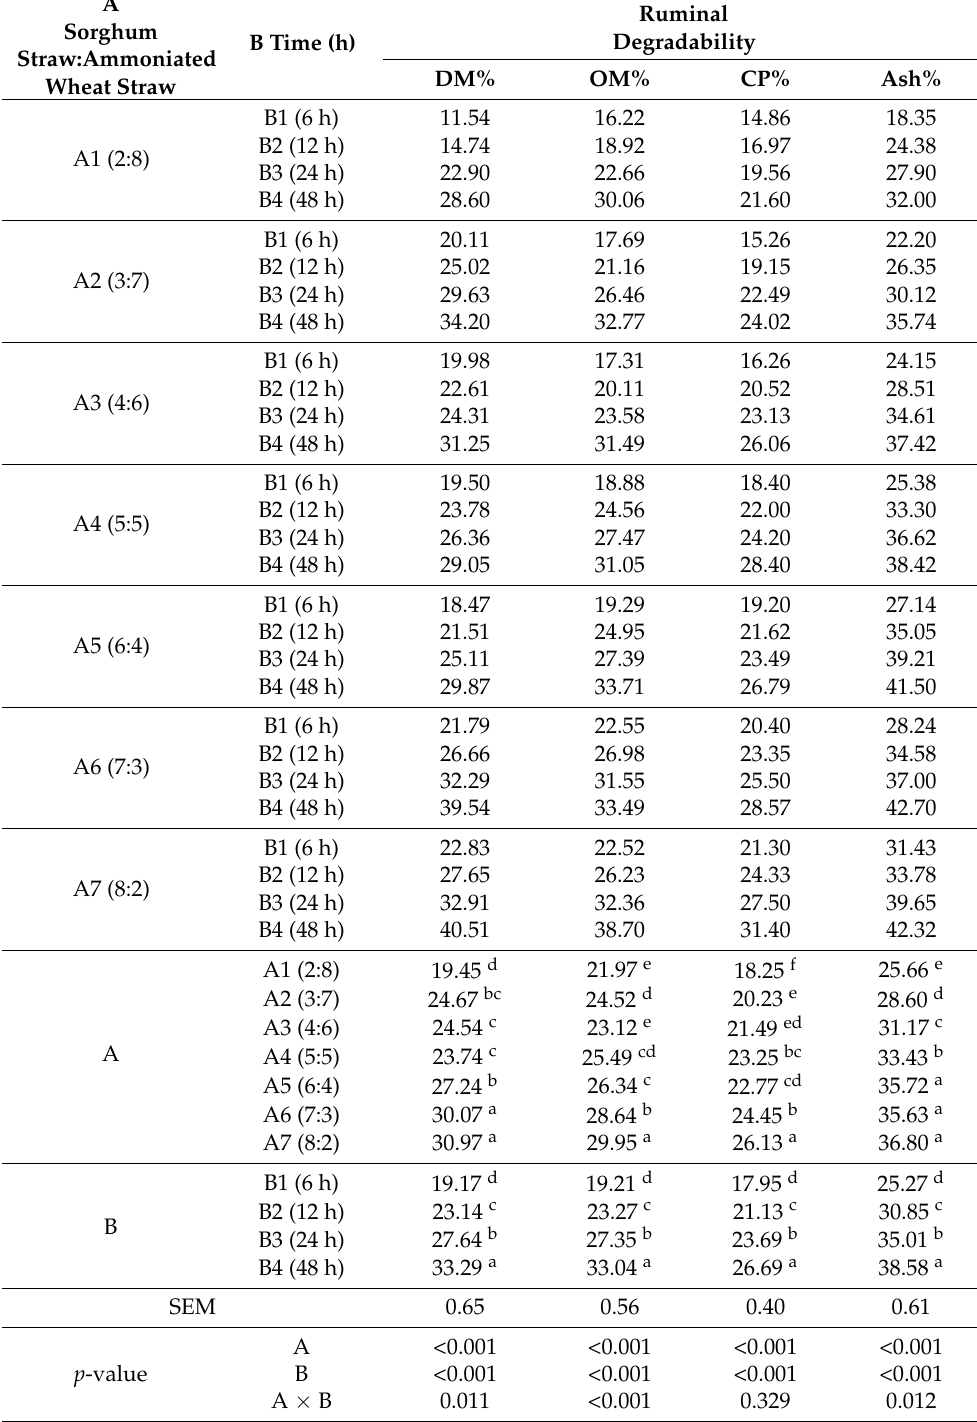
Table 3. Effects of different proportions of sorghum straw and ammoniated wheat straw on rumen dry matter, organic matter, crude ash, and crude protein degradability at different time